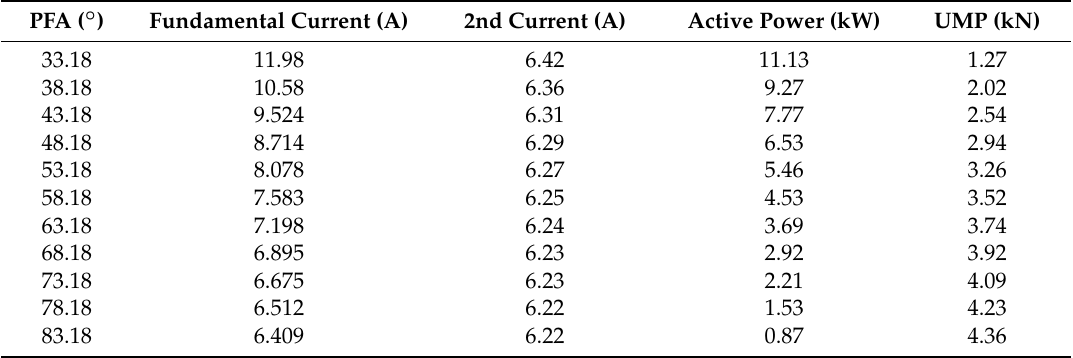
Table 7. Operation data of A1552 model machine field winding on taps 2–4 short circuit. PFA: power factor